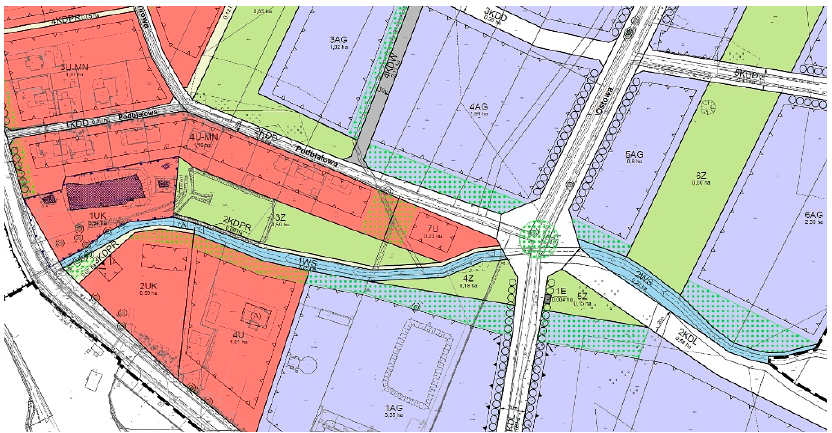
Figure 2. Green zones (marked with an openwork gradient) designated in the areas of functions: service (U), economic activity (AG) and public roads (KDL), except for strictly functionally defined green areas (Z). Source: [28].